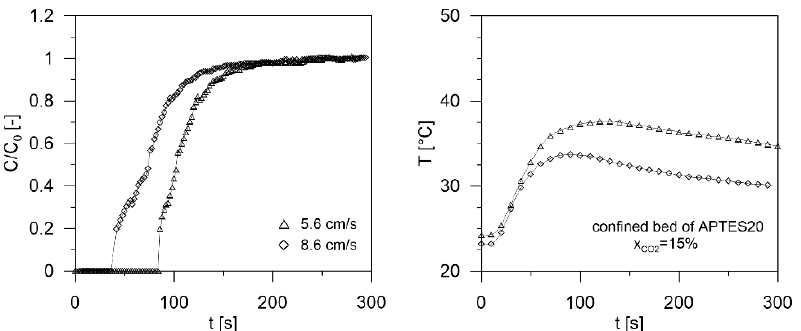
Figure 13. Effect of gas velocity on the breakthrough curves for APTES20 in conventional bed with 15% CO 2 .